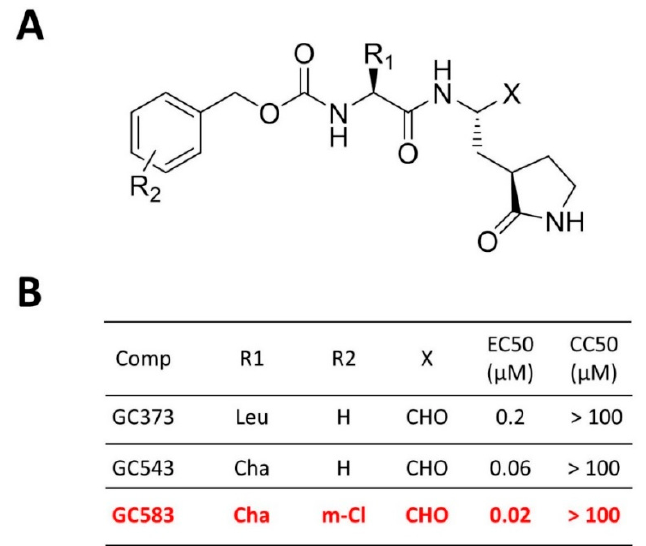
Figure 8. Examples of optimization strategy employed for the dipeptidyl compounds against norovirus from one of the initial hits ( GC373 ). Potency increased by making changes in R 1 and R 2 . Red color indicates the most optimized GC583 .